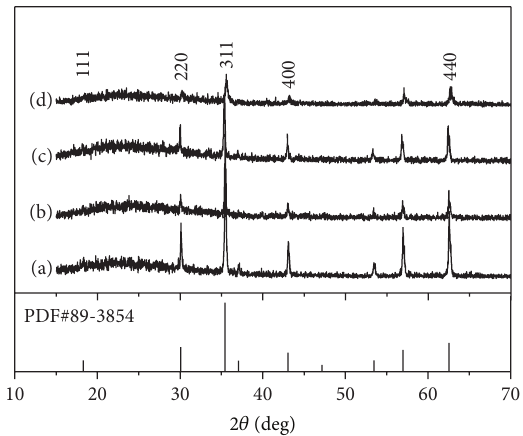
Figure 1: Powder XRD patterns of the products obtained using different amounts of NaOH: (a) 2.0 mmol (pH = 7), (b) 3.75 mmol (pH = 8), (c) 5.0 mmol (pH = 9), and (d) 12.5 mmol (pH > 14). The bars are from JCPDS Card No. 89-3854 for spinel-structured Fe 3 O 4 .